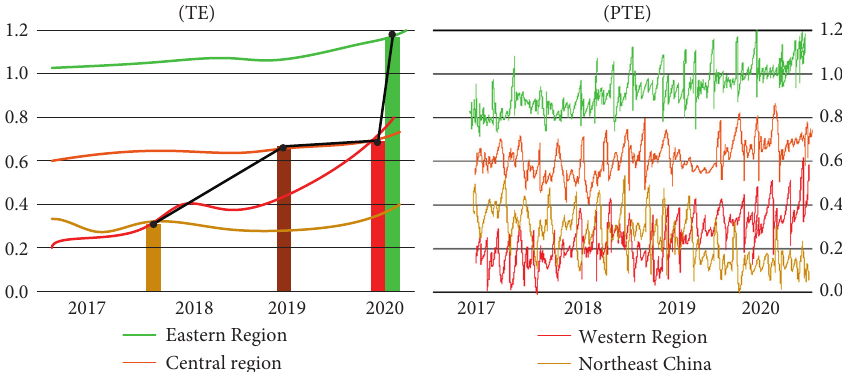
Figure 8: Comparative change diagram of TE and PTE in each region.